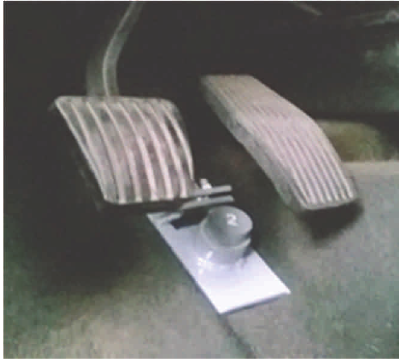
Fig. 4. View of accelerator pedal limiter